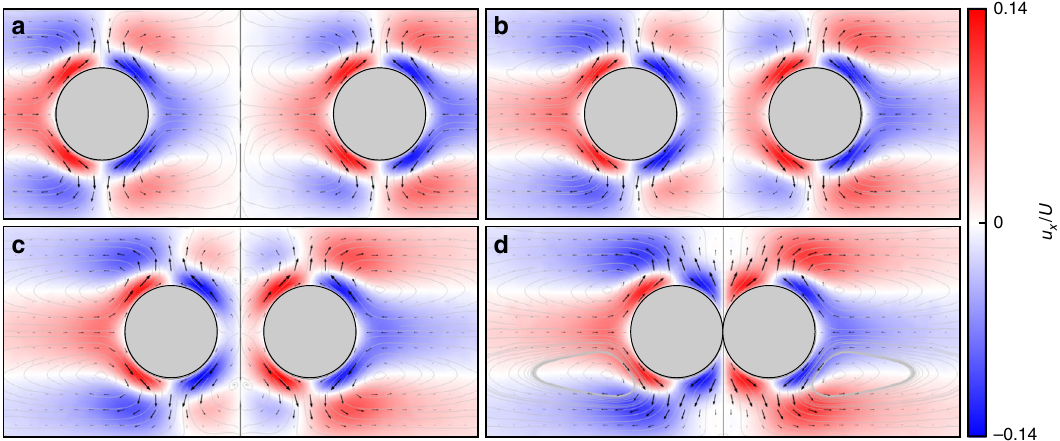
Fig. 5 Flow structures created by two spheres. Four different fi xed separation distances ( a 4, b 2, c 1, and d 0 radii), with fl ows computed assuming Pe ¼ 5 : 35, σ ¼ 0 : 03 g cm − 4 , and a ¼ 0 : 045 cm, scale bar on the right normalized by Phillips velocity U .